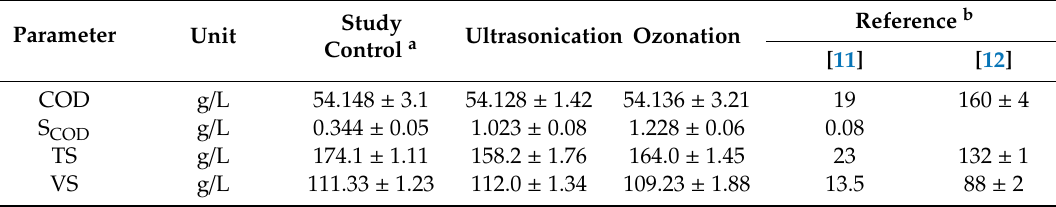
Table 1. Characteristics of sludges before and after